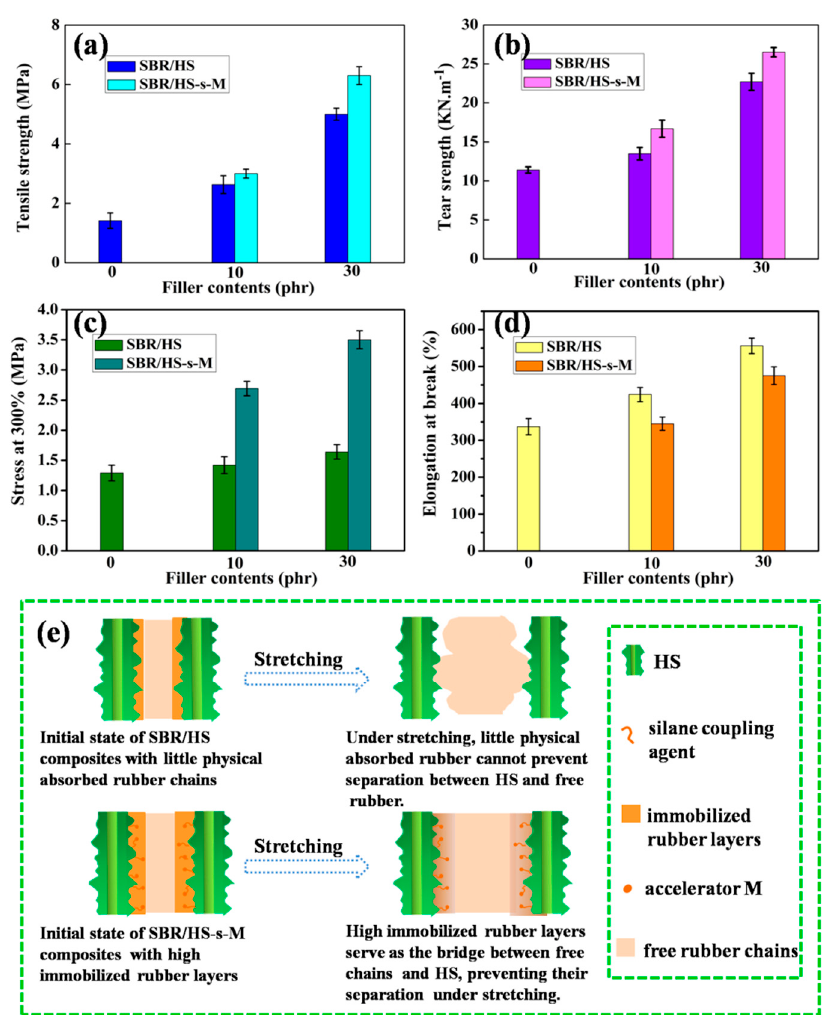
Figure 9. ( a ) Tensile strength, ( b ) Tear strength, ( c ) Stress at 300%, and ( d ) Elongation at break of SBR composites; ( e ) proposed model for the structural change of rubber chains in the rubber-filler interfacial region during stretching.